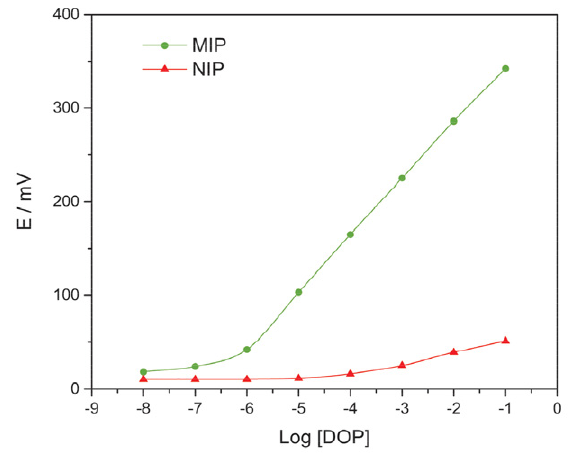
Figure 4. Calibration curves of the DOP-selective sensors based on MIP (•) and NIP (  )